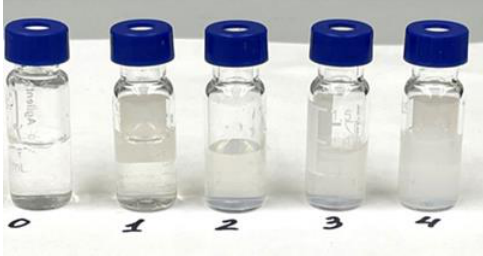
Figure 4. Photographs of the MFC suspension with nanofiber contents of ( 0 ) 0.5, ( 1 ) 1.0, ( 2 ) 1.5, ( 3 ) 2.0, and ( 4 ) 3.0 mg/L.